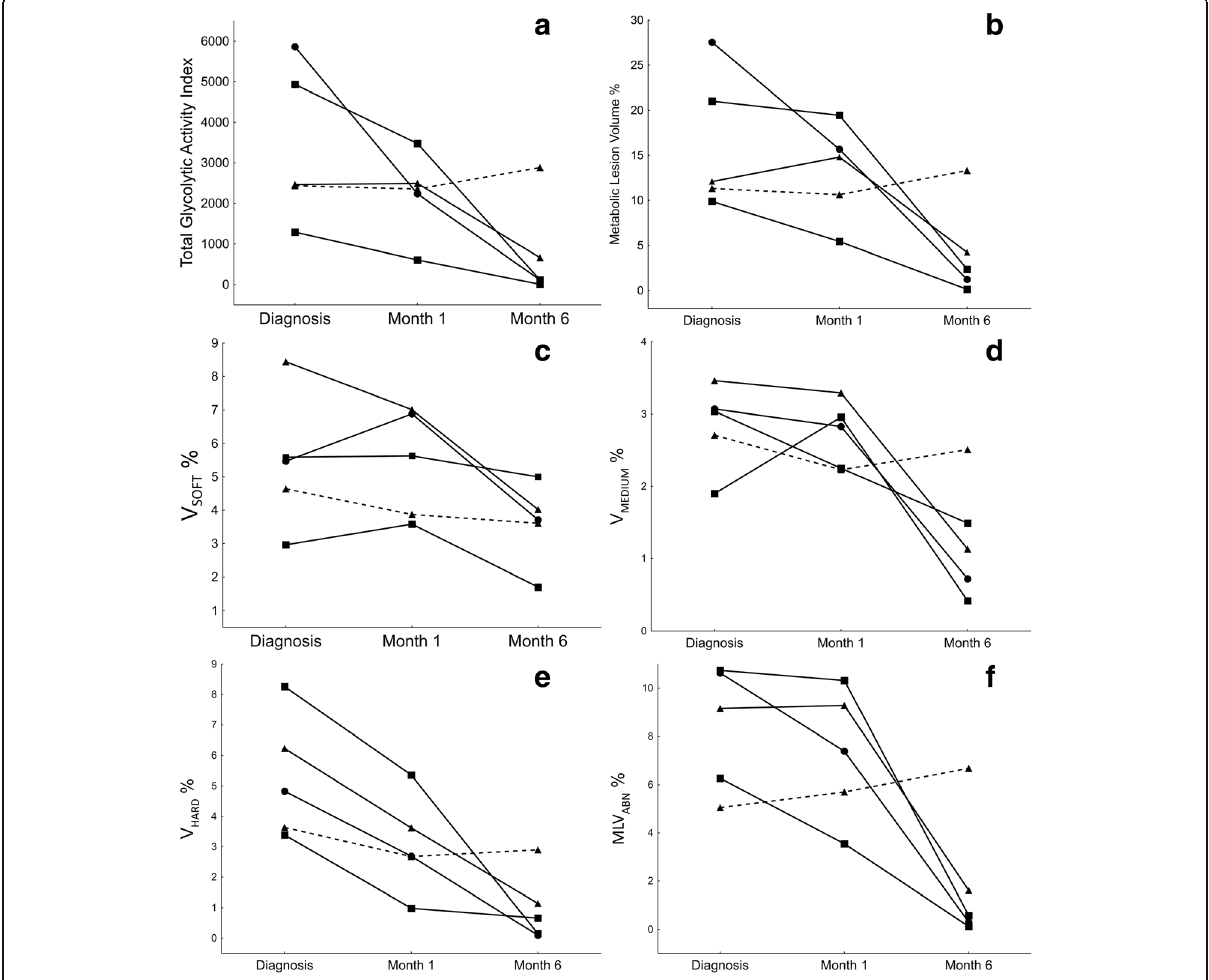
Fig. 8 These graphs represent the case-profiles of five different PTB patients and the changes of various auto-segmented PET-CT parameters at Dx, M1 and M6 ( X axis). A straight line represents a cured outcome and the broken line indicates treatment failure. a Total glycolytic activity index. b Metabolic lesion volume as a percentage of total lung volume. c V soft ( − 500 HU: − 300 HU) CT lesion volume as a percentage of total lung volume. d V medium ( − 300 HU: − 100 HU) CT lesion volume as a percentage of total lung volume. e V hard (> − 100 HU) CT lesion volume as a percentage of total lung volume. f Area of lung that shows abnormal density (> − 500 HU) and relative high uptake intensity as a percentage of total lung